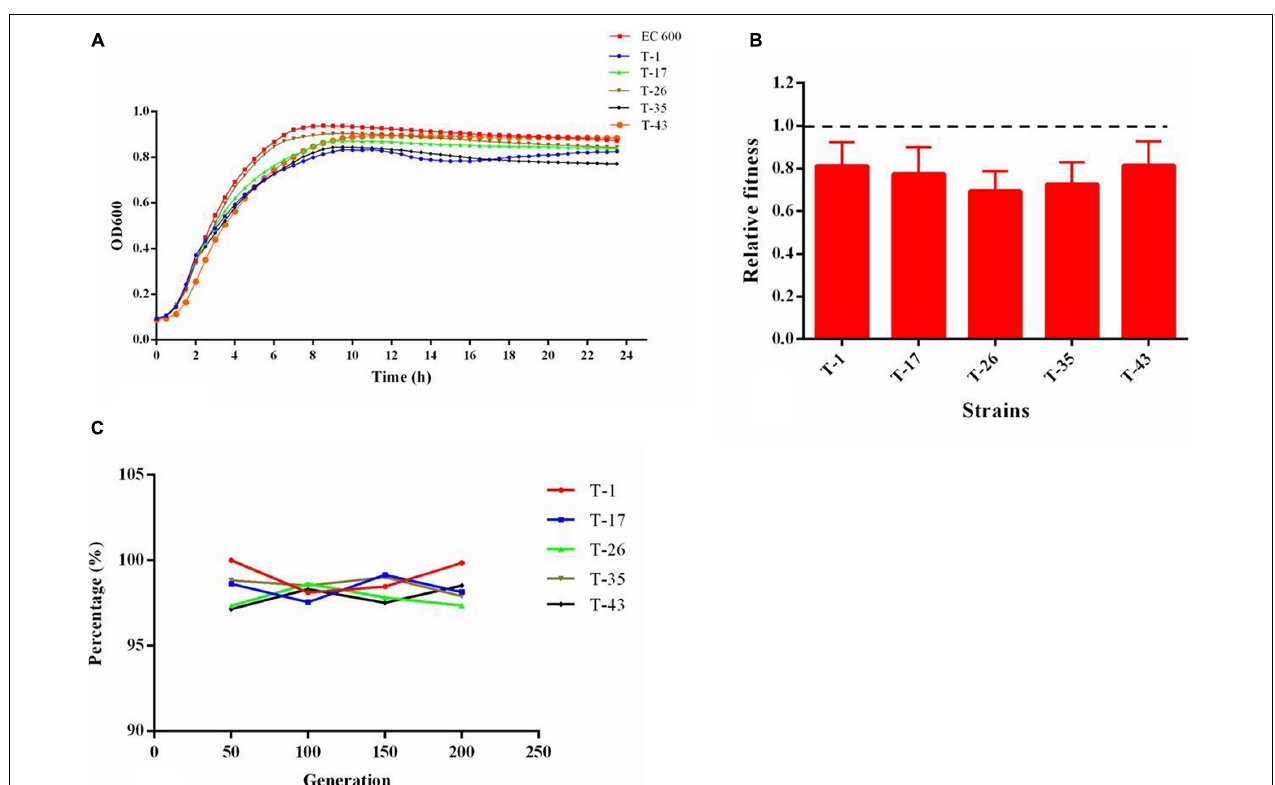
FIGURE 6 | (A) Growth kinetics of transconjugants harboring mcr-1 ; (B) relative fitness of transconjugants harboring mcr-1 , a relative fitness of 1 indicates that the transcoujugants undergo no fitness cost; (C) stability of plasmid harboring mcr-1 in